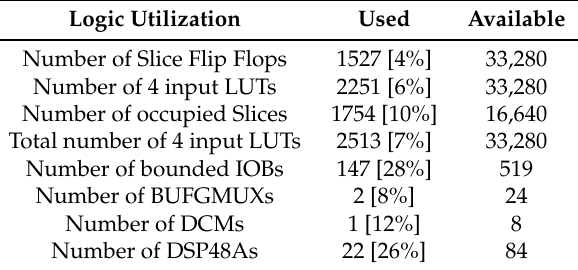
Table 1. Device use